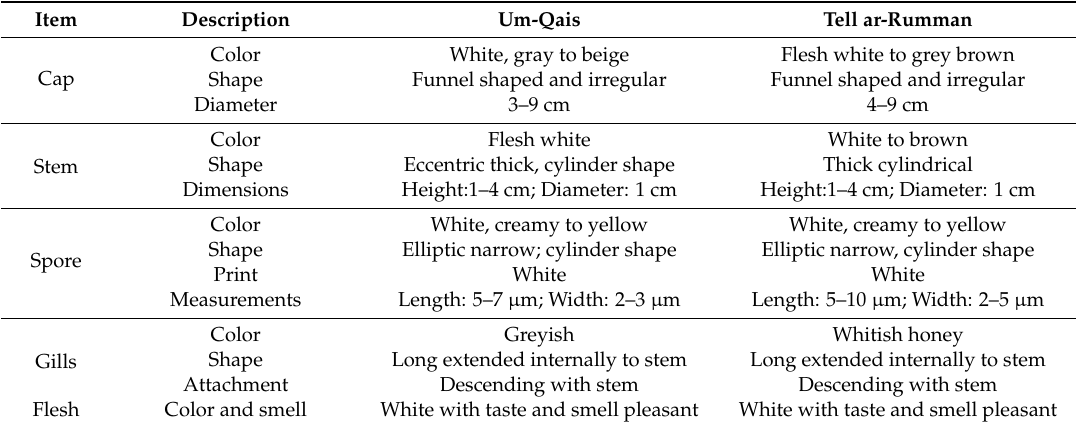
Table 1. Morphological characteristics of mature Pleurotus Mushroom’s Fruit Bodies and spores collected naturally from two different locations across Jordan.